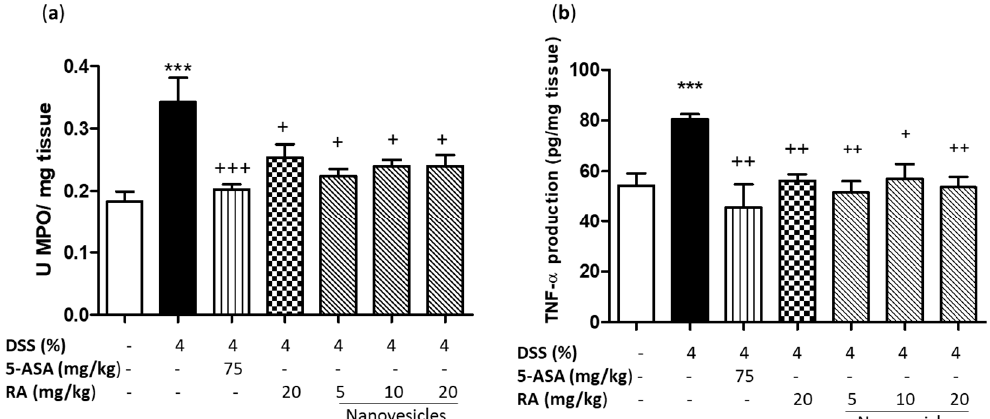
Figure 4. Effects of rosmarinic acid (RA)-loaded nanovesicles (5, 10 and 20 mg/kg), RA (20 mg/kg) or aminosalicylic acid (5-ASA) (75 mg/kg) on myeloperoxidase activity ( a ) and tumor necrosis factor alpha levels ( b ) in DSS-induced colitis in mice. Data are expressed as the mean ± SEM. Mean value was significantly different compared with the sham group (*** p < 0.001; Student t test). Mean value was significantly different compared with DSS group (+ p < 0.05, ++ p < 0.01, +++ p < 0.01; one-way ANOVA followed by Bonferroni’s Multiple Comparison test).